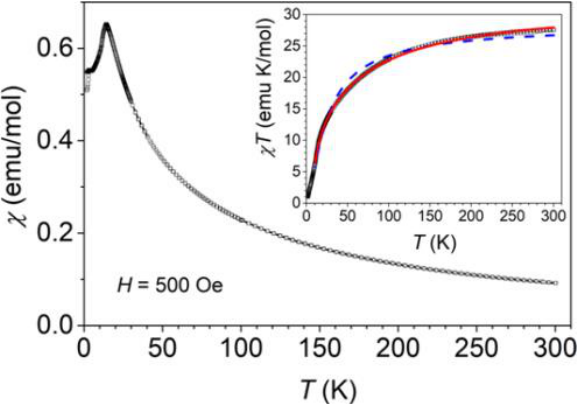
Figure 4. Temperature dependent susceptibility of Co 3 (AsO 4 ) 0.5 (HAsO 4 ) 2 (H 2 AsO 4 ) 0.5 ·(H 2 O) 0.5 and the product χ T versus temperature (inset). Blue dashed line is a fit with Equation (1), red full line is a fit with Equation (2).